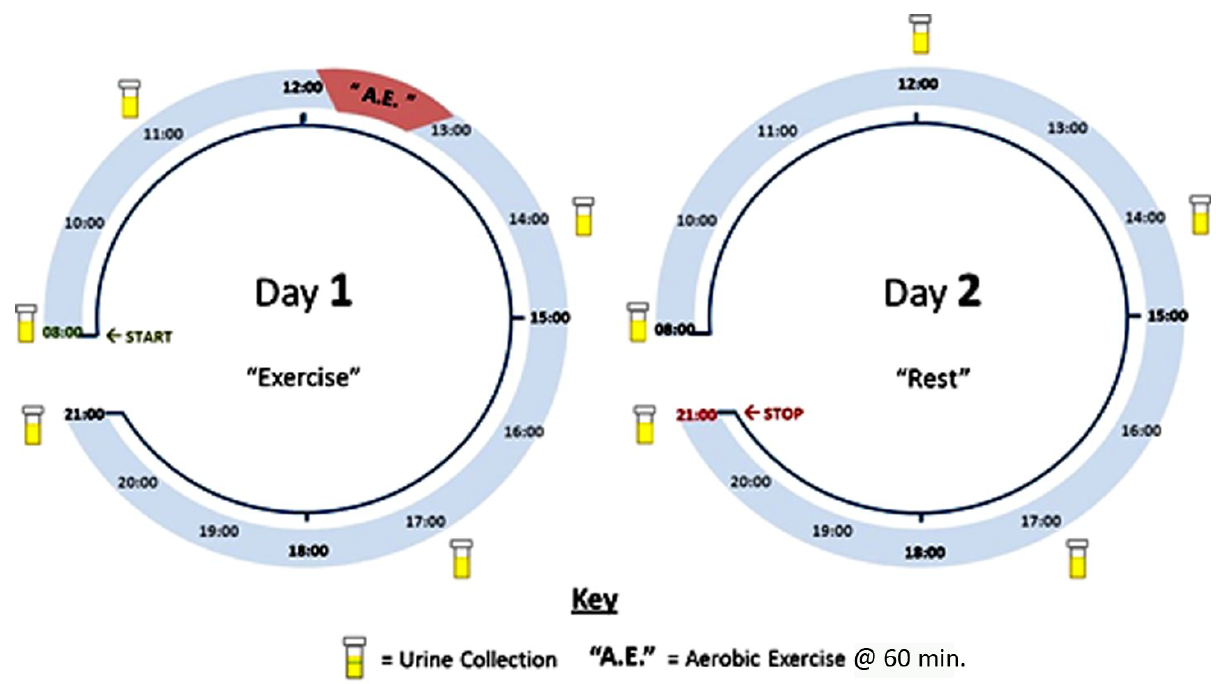
Figure 1. Illustration of experimental design and sample